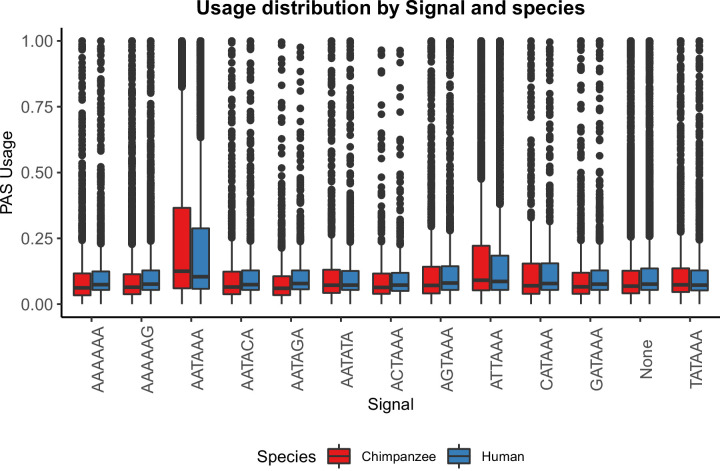
PAS with AATAAA and ATTAAA are used more often.Mean PAS usage of the top two signal site motifs in human and chimpanzee plotted by annotated signal site.